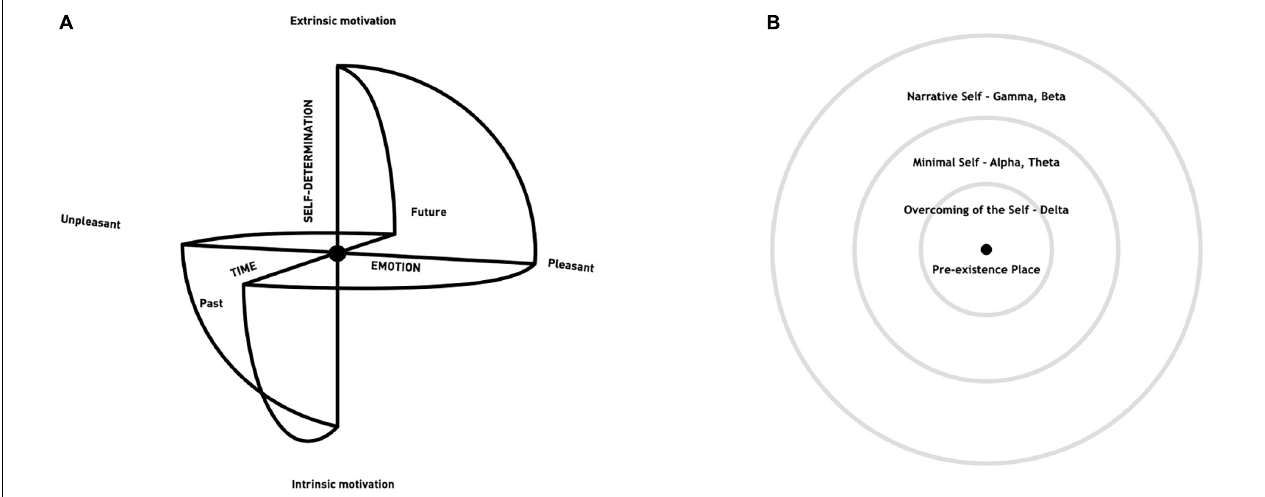
FIGURE 1 | (A) The Sphere Model of Consciousness. (B) Different Selves in the SMC and their main suggested electrophysiological correlate. The Narrative Self is related to Gamma and Beta, the Minimal Self is related to a shift toward Alpha and Theta (Carhart-Harris et al., 2014), and Overcoming the Self is mostly related to Delta activity (Dor-Ziderman et al., 2013; Paoletti et al., 2020). Adapted from Paoletti and Ben-Soussan (2019,